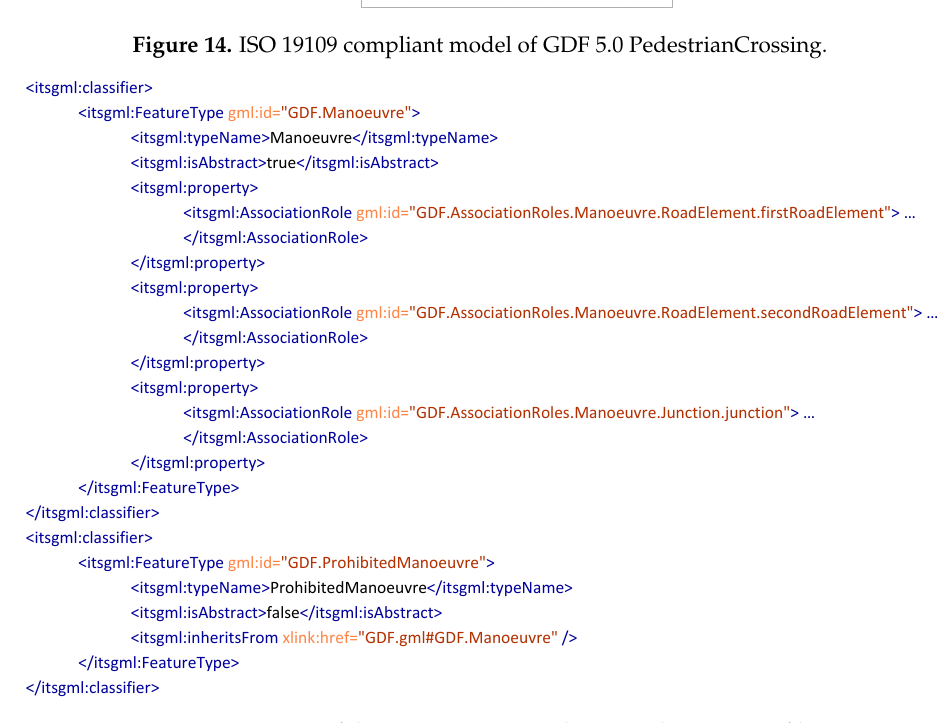
Figure 15. Extract of the GDF Feature Catalogue Exchange GML file.